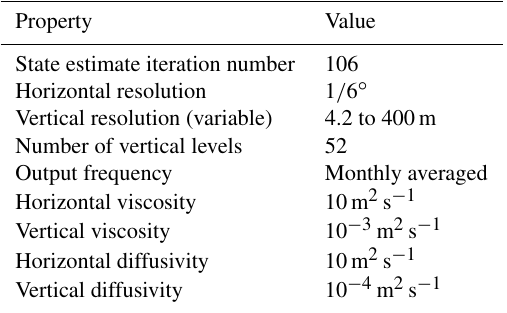
Table 1. Selected properties of B-SOSE iteration 106. Output fre- quency refers to the output selected for this